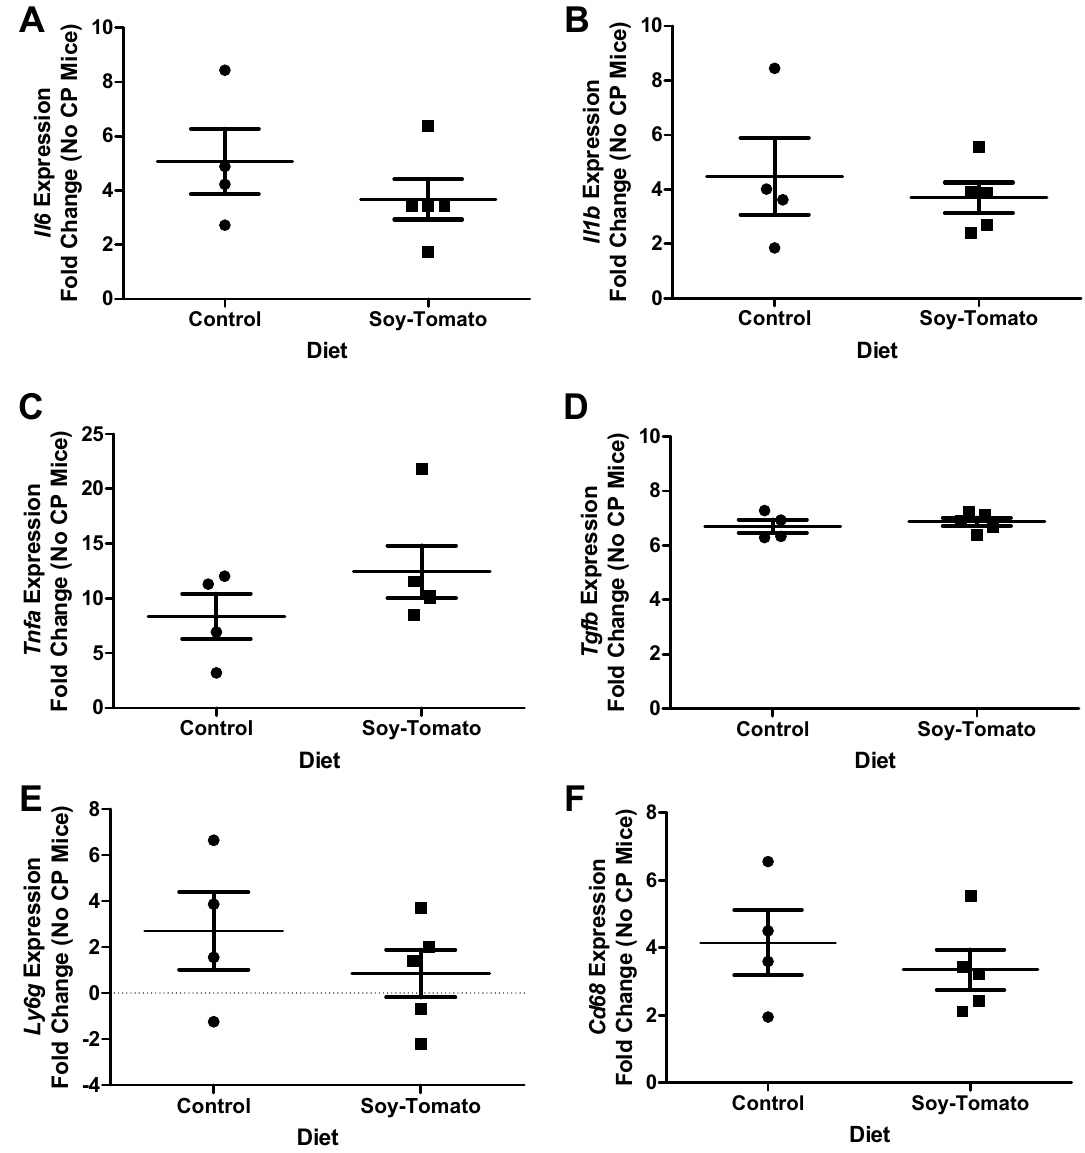
Figure 5. Soy-tomato diet reduces inflammatory gene expression in pancreatic tissue of mice with CP. At study endpoint, mice pancreata were harvested and placed in RNALater. Tissue samples were used to extract RNA and synthesize cDNA for RT-qPCR analysis of genes of interest. Gene expression was quantified and normalized to the 18S housekeeping gene and then normalized to healthy mice without CP. Expression levels of pro- inflammatory cytokines ( A ) IL-6, ( B ) IL-1beta, ( C ) TGF-alpha, ( D ) TNF-beta, and inflammatory cells such as ( E ) Ly6G and ( F ) CD68 were analyzed by RT-qPCR. N = 5